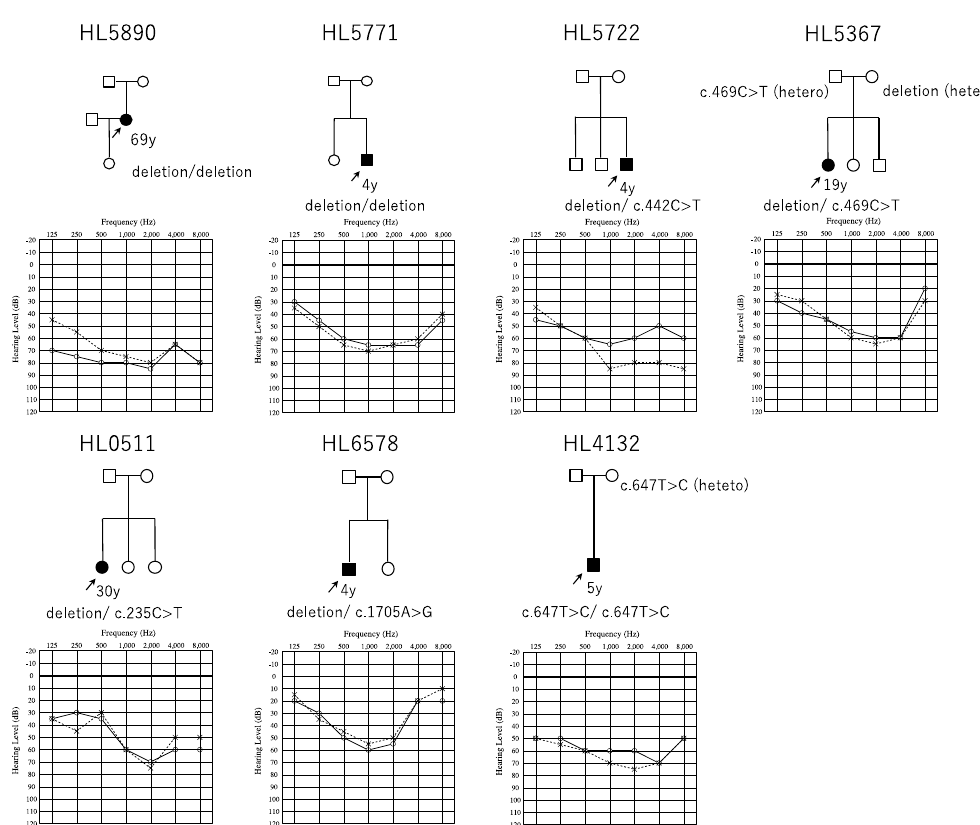
Figure 1. Pedigree and audiograms for each family with OTOA variants. Arrows show the probands in each family. The ages indicated in the pedigree represent the time at which the audiogram was obtained. Genetic findings for each individual tested are also noted in the pedigree.